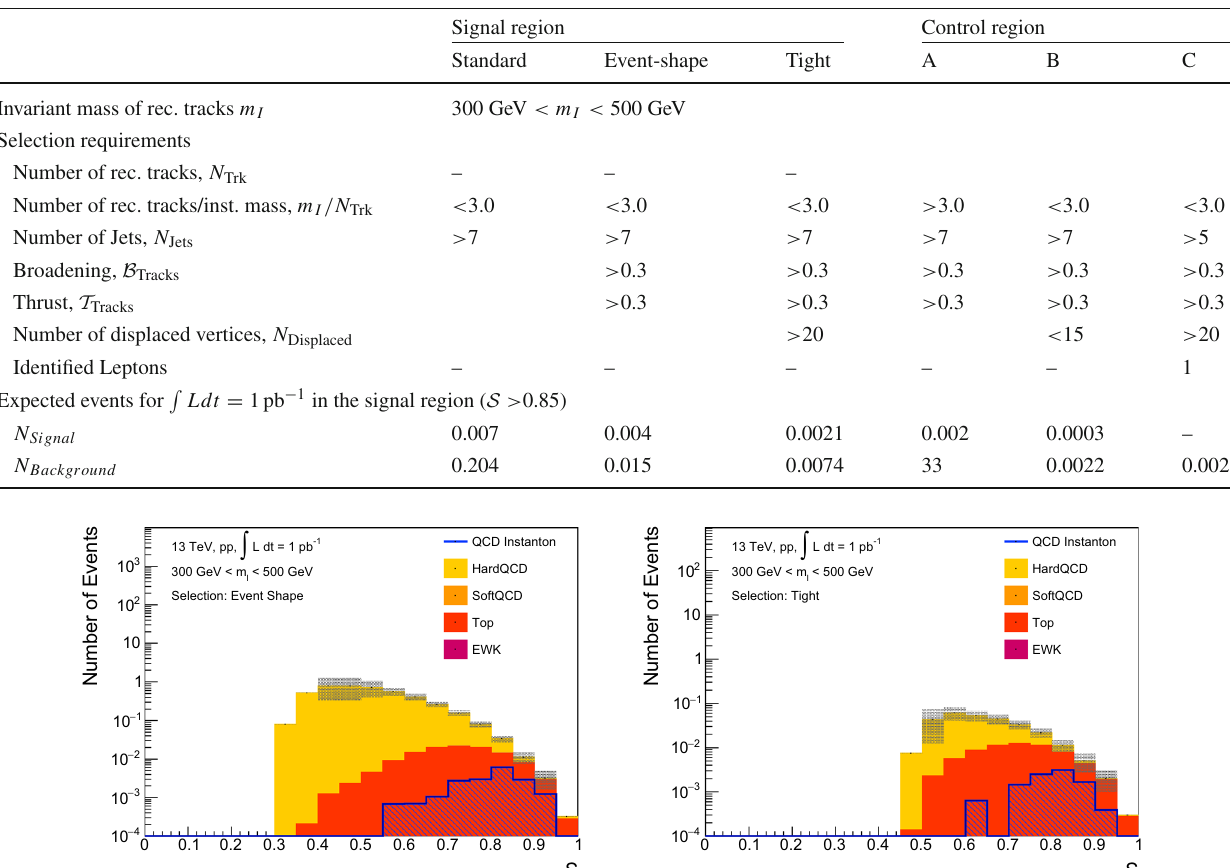
Table 6 Overview of the standard and tight signal selection as well as the definition of two control regions aiming at very low Instanton masses (300 GeV < m